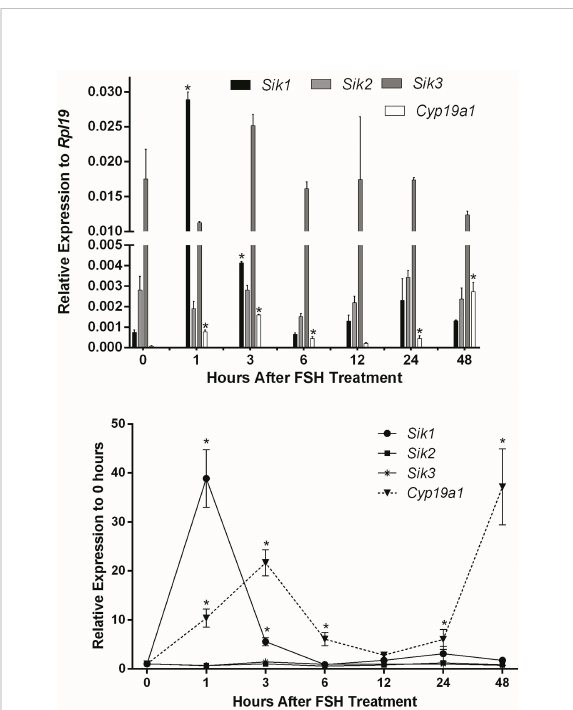
FIGURE 1 Effect of FSH on SIK expression. Rat GCs were treated with FSH (50 ng/ml). The mRNA levels for Cyp19a1 , Sik1 , Sik2 , and Sik3 were measured 1, 3, 6, 12, 24, and 48 h after the initiation of treatment. The expression of each gene is plotted as relative expression to Rpl19 (Top) or relative to 0 h (Bottom). One-way ANOVA followed by Tukey. * p < 0.05, n =